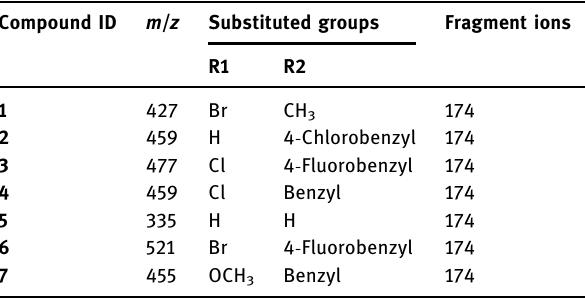
Table 1: List of compounds with their fragment